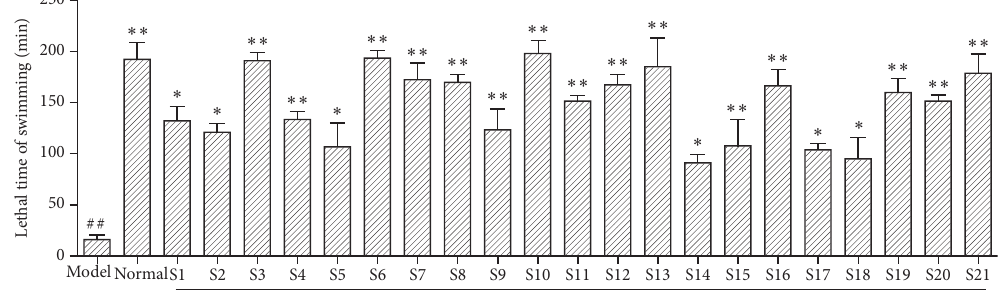
Figure 4: Results of tonifying spleen and tonifying Qi of saponins in Glycyrrhiza uralensis Fisch. from 21 producing areas. The result represents mean ± S.D.